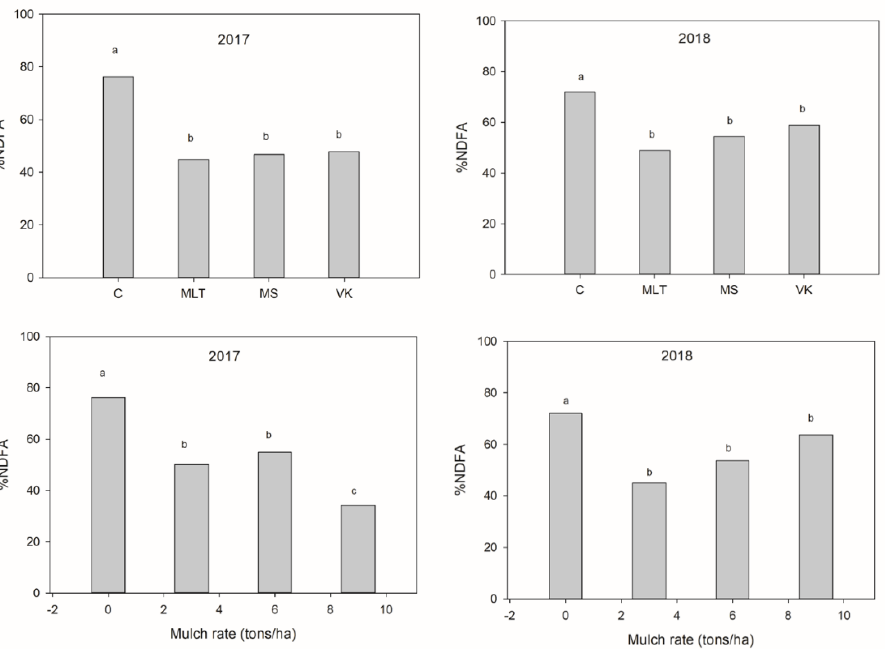
Figure 5. The effect of mulch type and mulch rate on biological nitrogen fixation (BNF) at Ofcolaco in 2017 and 2018. MLT is Moringa Oleifera leaves and twigs; MS is M. Oleifera stems; VK is Vachelia Karoo leaves and twigs, and C is the control where no mulch was applied. Different letters (a, b, c) on the bars show significant differences.